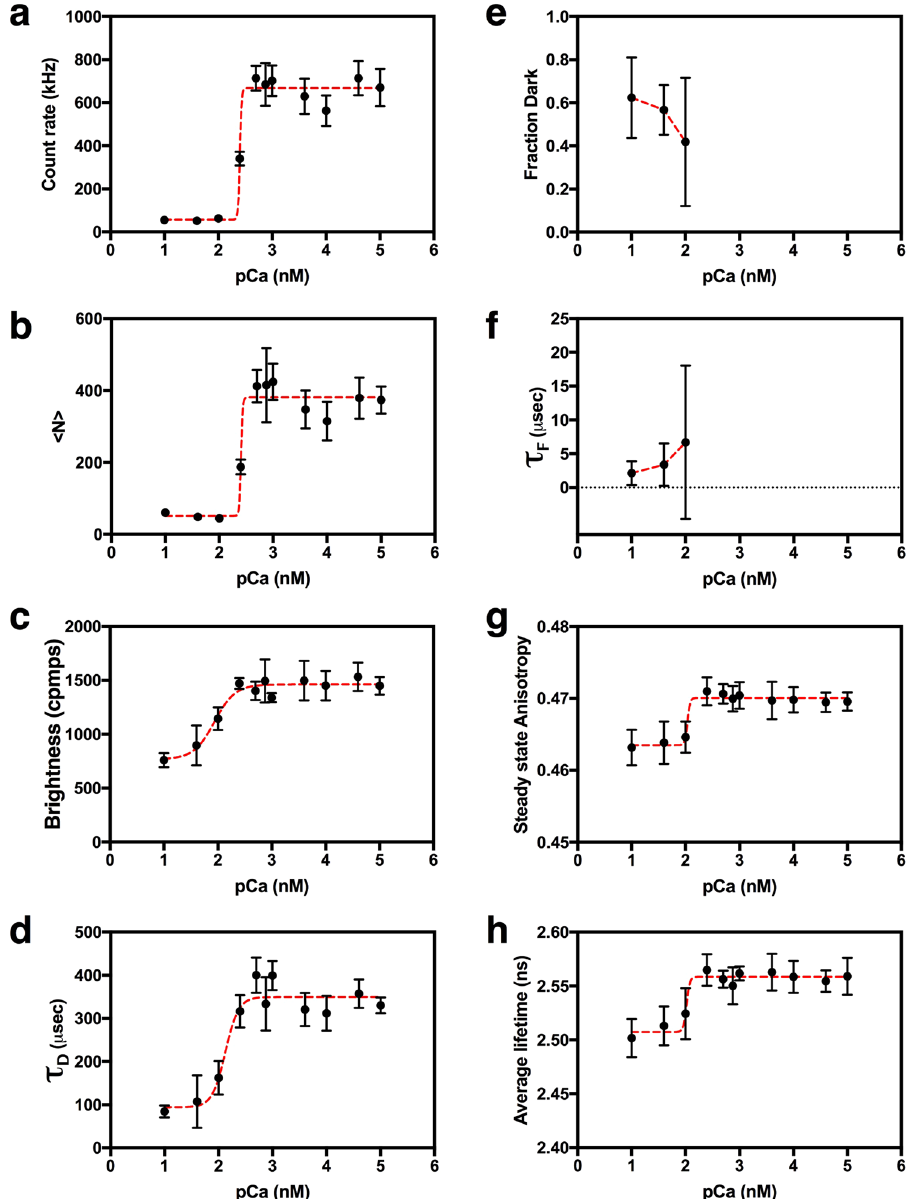
Figure 10. Auto-FPFA characterization of GCaMP6s, an intensity based calcium biosensor. Auto-FPFA was used to measure count rate ( a ), < N > ( b ), brightness ( c ), τ D ( d ), fraction dark state ( e ), τ F ( f ), steady state anisotropy ( g ), and average lifetime ( e ) of two different homogenates prepared from cells expressing GCaMP6s. Homogenates were diluted into buffers with defined calcium concentrations. The homogenate concentration was six times as concentrated for samples at or below 250 nM calcium as those used at higher calcium concentrations. Each point is the mean ± SD (N = 4, two from each homogenate preparations). Dashed lines are a four parameter, variable slope dose-response fit in all panels except for panels e and f where the dashed lines simply connect the three data